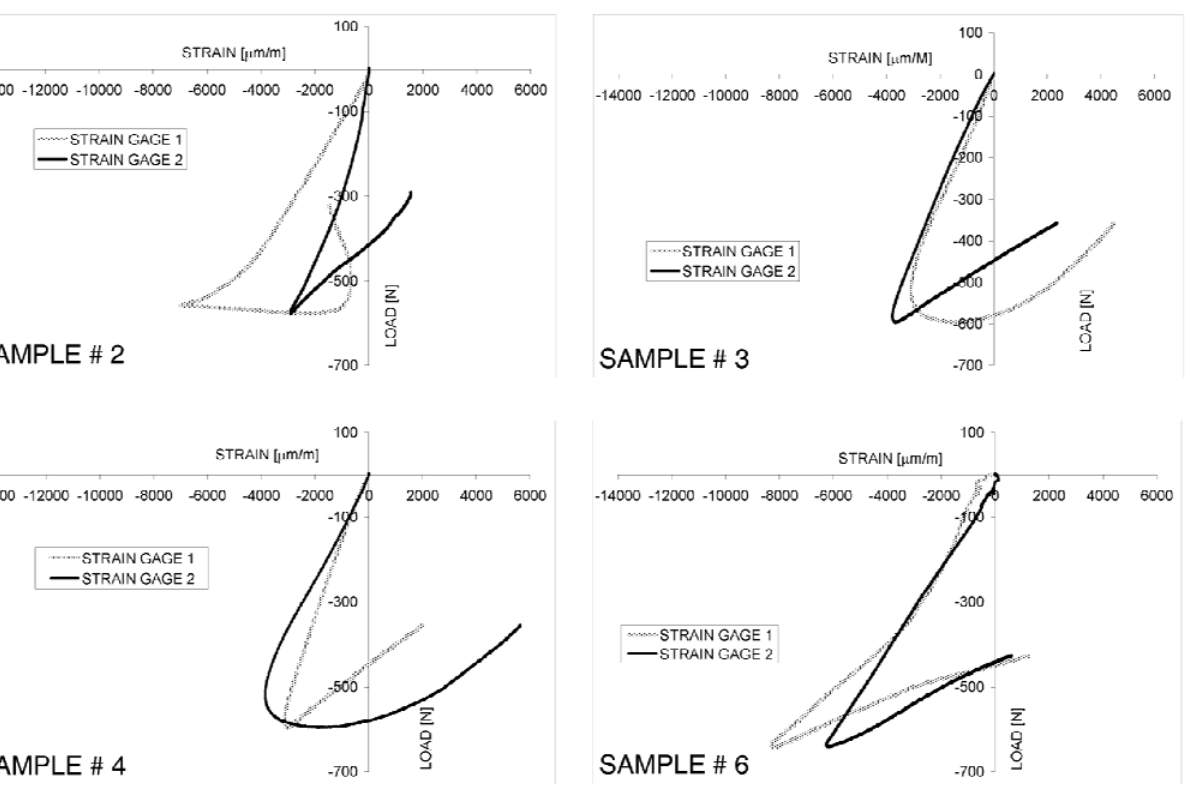
Figure 5. Typical strain-load curves obtained in the edgewise-compression tests of foam-based sandwich